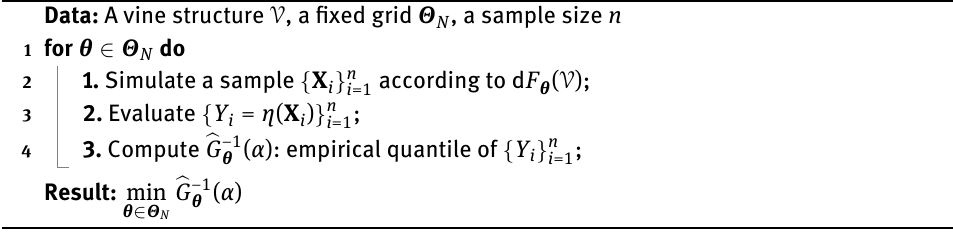
Algorithm 1: Exhaustive Grid-Search algorithm to minimize the output quantile. Data: A vine structure V , a fixed grid Θ N , a sample size